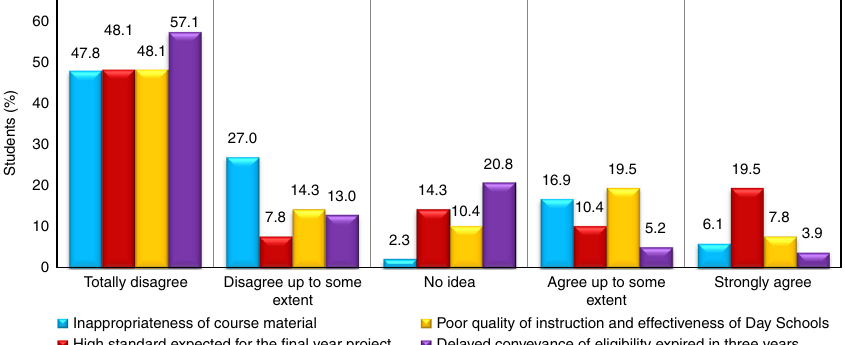
Figure 3. Institutional barriers